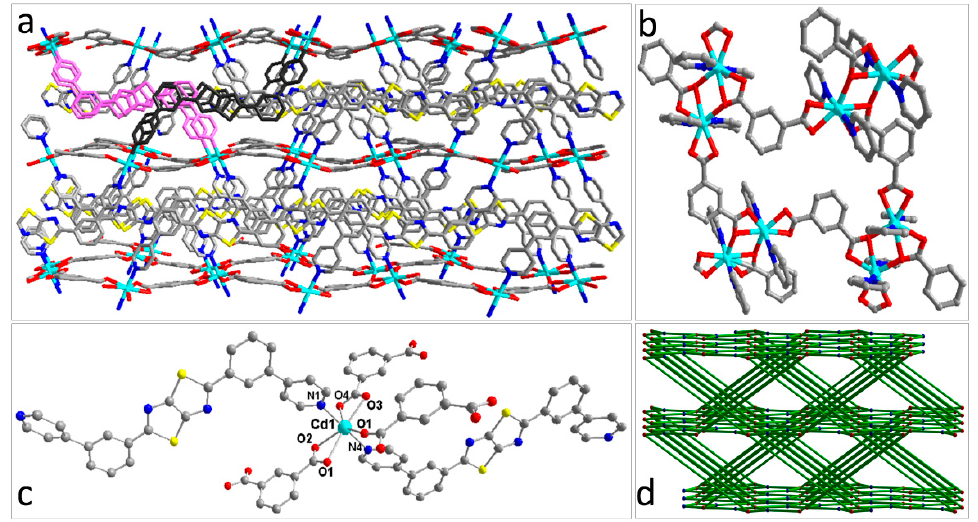
Figure 2. The 3D network of 2 ( a ), the 2D [Cd(IP)] n layer in 2 ( b ), the coordination environment of Cd(II) in 2 ( c ), and the topological network formed in 2 ( d ); red spheres represent Cd(II) centers, blue spheres represent the isophthalic acid (IP − ) ligands. Molecules 2020 , 25 , x FOR PEER REVIEW